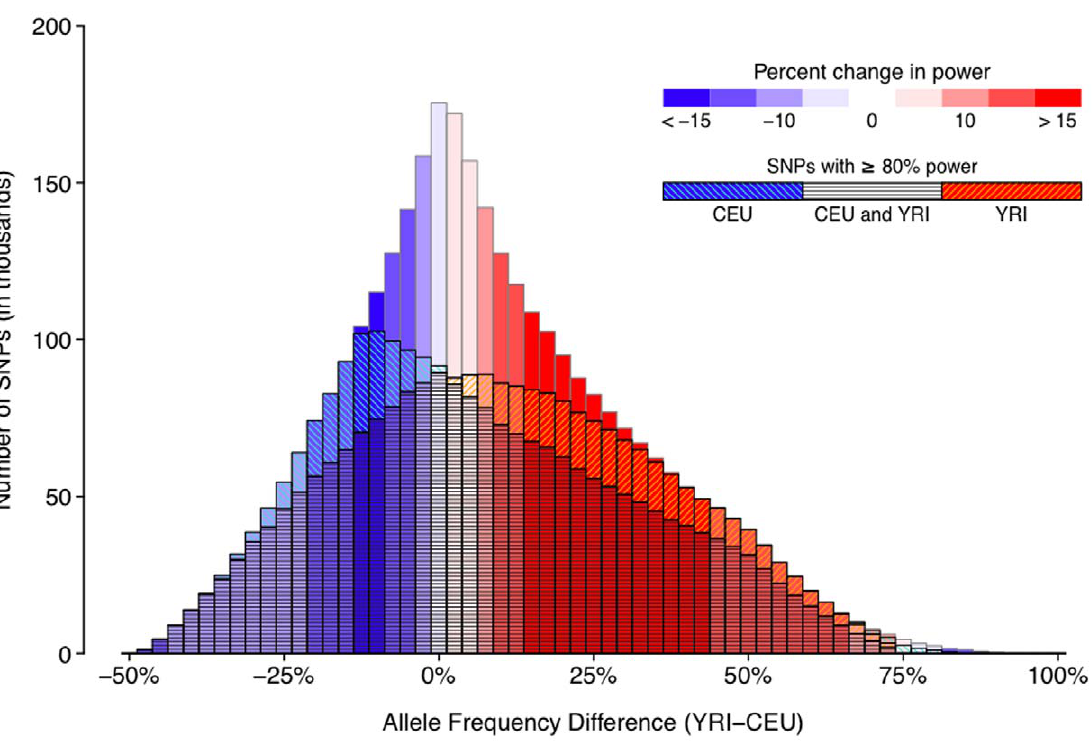
Figure 5. The relationship between allele frequency differences between CEU and YRI and power. We plot the histogram of all SNPs in the 1000 Genomes Project data as a function the allele frequency difference between CEU and YRI (excluding SNPs monomorphic in both CEU and YRI). The histogram is colour-coded by the estimated change in power by performing phase 2 in YRI instead of CEU, assuming a total sample size of 20,000 (10,000 in CEU in phase 1, and 10,000 in YRI in phase 2) and a GRR of 1.2. Allele frequency differences from + 15% to + 40% in YRI result in a positive gain in power (in red), which is compensated by SNPs that are common in CEU (in blue). We divide the histogram into 4 categories: (1) SNPs with at least 80% power in both scenarios (CEU in phase 2 or YRI in phase 2) (65.6% of all SNPs considered), (2) SNPs with at least 80% power to detect an association in the European GWAS (CEU in phase 2) (6.5% of all SNPs considered), (3) SNPs with at least 80% power in the African GWAS (YRI in phase 2) (9.3%), and (4) SNPs that do not reach 80% in either of these two scenarios (18.6%). As alleles of higher frequency in CEU are mostly saturated for power, including additional European samples in GWAS will only marginally increase power, whereas alleles of lower frequency in CEU may substantially benefit in terms of power from elevated frequencies in African populations.